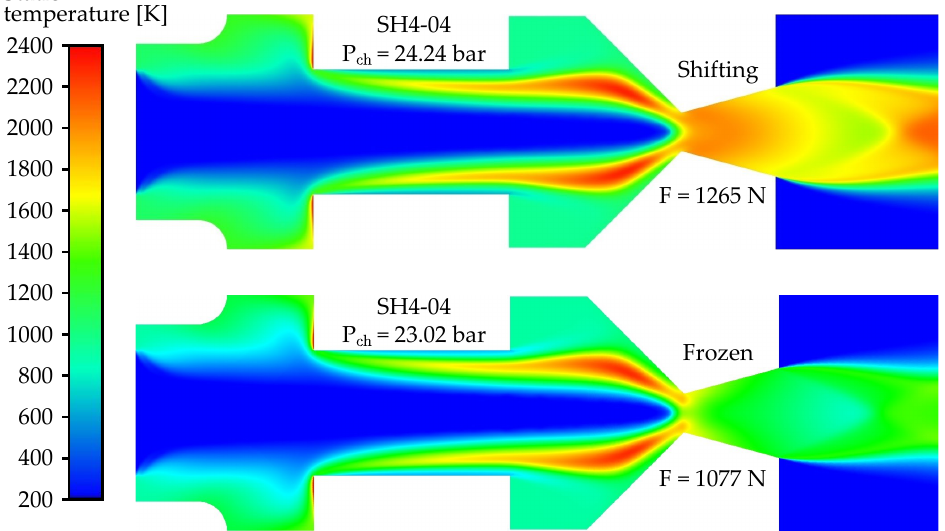
Figure 14. Static temperature field for case SH4-04, with shifting and frozen equilibrium.